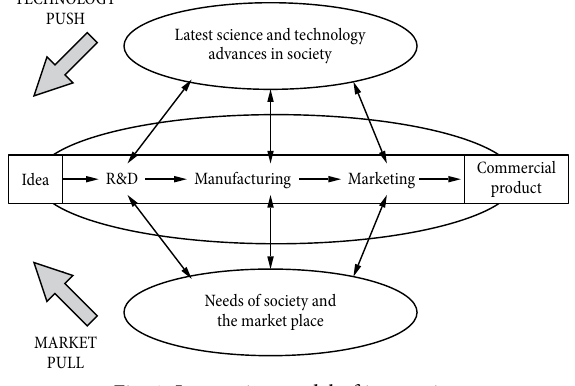
Fig. 1. Interactive model of innovation